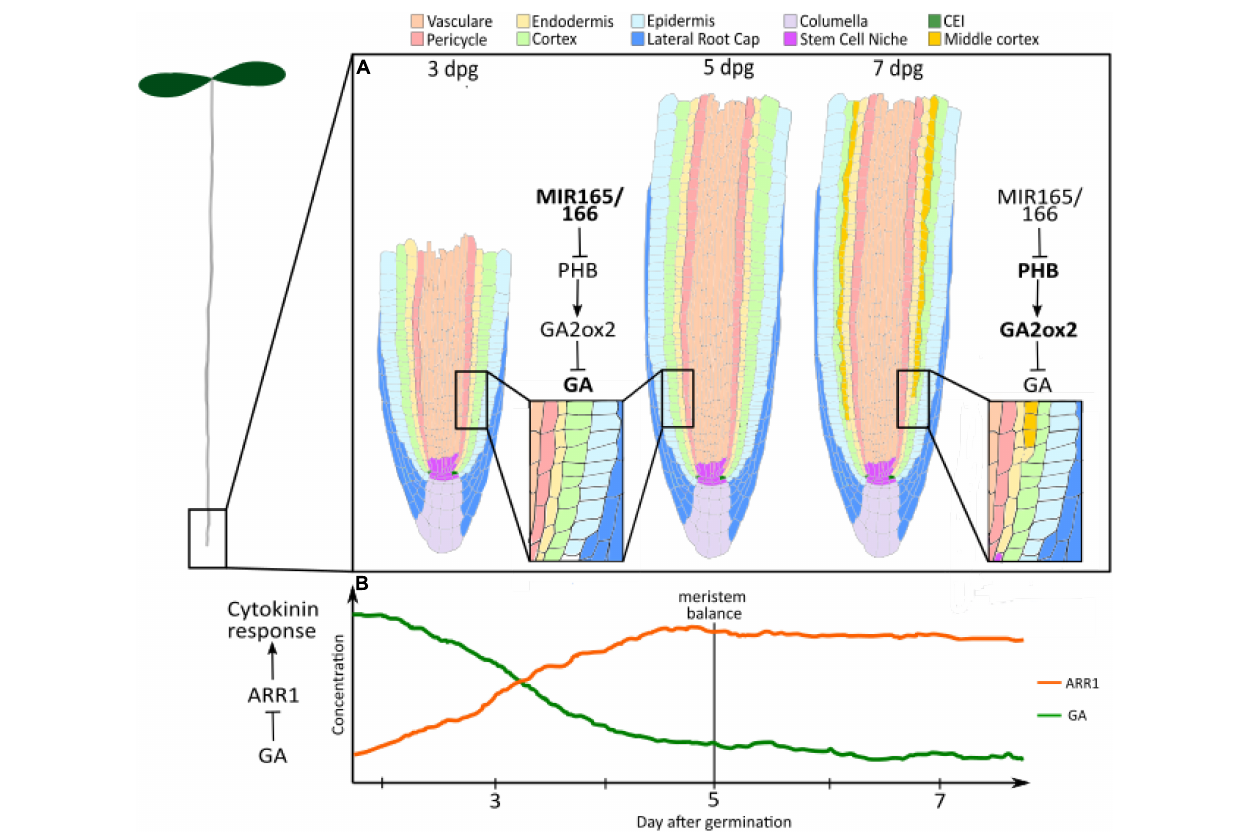
FIGURE 1 | Gibberellin controls longitudinal and radial dynamics. (A) GA levels regulate root radial axis patterning: High levels of Gibberellin between 3 and 5 dpg inhibit the formation of the MC. High concentration of miRNA 165 and 166 negatively regulate PHB levels. PHB controls the gibberellin degradation, promoting the expression of the GA2OX2 gibberellin catalytic gene. At 7–8 dpg, the levels of PHB increase as a consequence of miR165 and 166 reduction. PHB reduction results in enhanced GA2OX2 expression, which determines the degradation of GAs and MC formation. Salmon, Vasculature; Pink, Pericycle; Yellow, endodermis; Light green, cortex; cyan, epidermis; blue, lateral root cap; Lilac, columella; Purple, stem cell niche; Green, CEI; Ochre, middle cortex. (B) GA levels control root longitudinal axis patterning: Few days after germination, high GA levels activate cell division and repress cytokinin responses through the repression of ARR1 expression. The decline in GA levels from germination to 5 dpg allows for ARR1 expression. This induces an increase in cell differentiation, which balances cell division and sets meristem size. Orange, ARR1; Green, Gibberellin